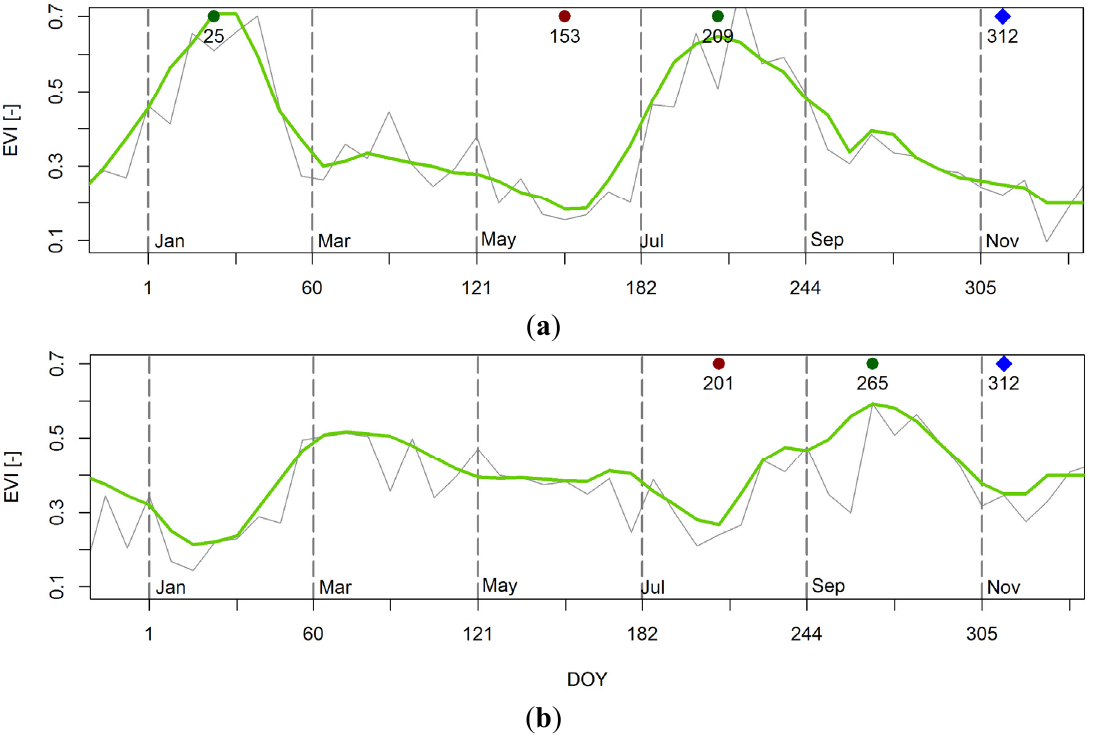
Figure 5. Time series analysis of EVI for a pixel located in the municipality of Kananga ( a ); 11°9.875 ′ N 124°30.631 ′ E) and Pastrana ( b ); 11°14.375 ′ N 124°51.303 ′ E) showing differences in planting dates during the wet season. The graphs show raw (thin black line) and smoothed EVI (green line); detected transplanting date (red point), heading occurrence (green point) and the typhoon Haiyan (blue diamond) together with their date of occurrence in DOY. Y-axis is EVI [–] and X-axis is time in